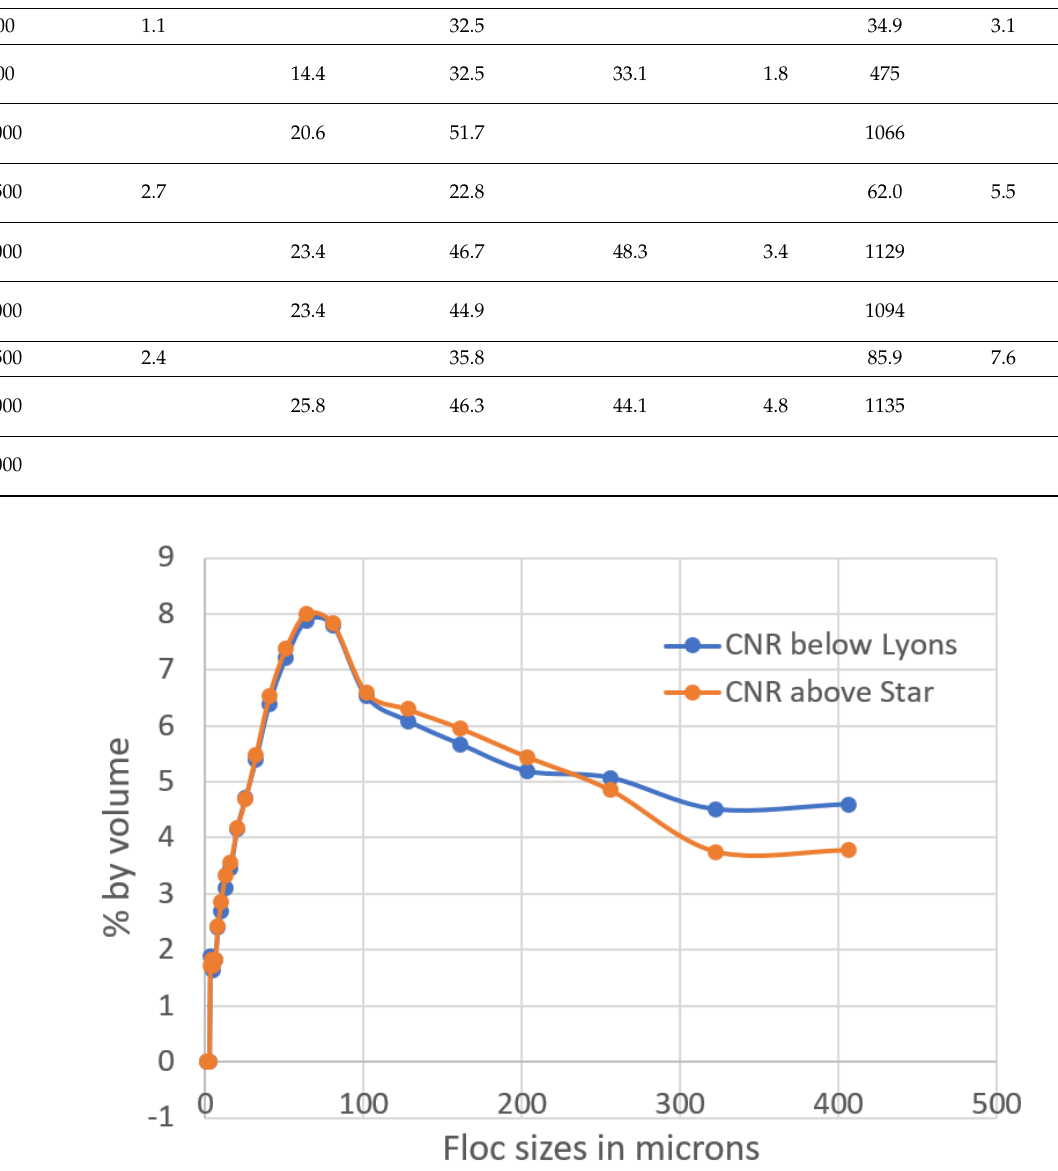
Figure 7. Effective particle size distributions of suspended sediment at two stations in the upper Crowsnest River.